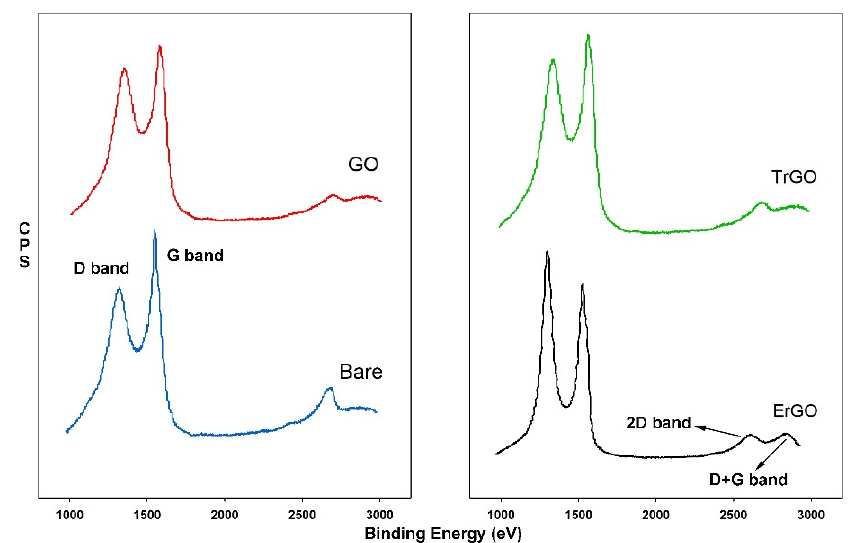
Figure 3. Raman spectra obtained from a bare electrode and electrodes modified with GO, ErGO, and TrGO. The I D /I G ratios were 0.77, 0.88, 1.15, and 0.89, respectively .